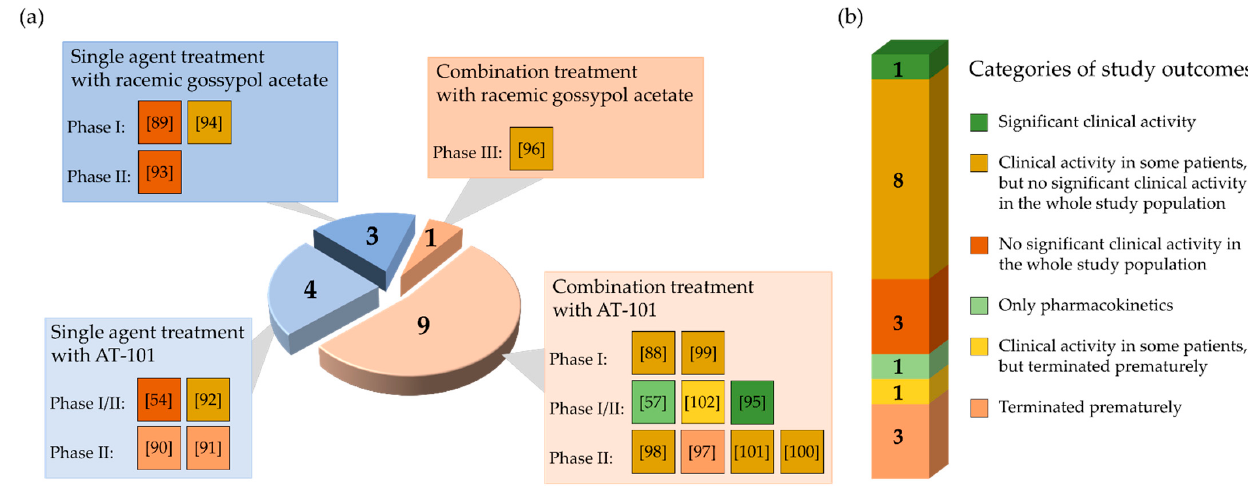
Figure 4. Graphical representation of the results of reviewed studies in cancer clinical trials analyzing the administration of gossypol/AT-101 as a single agent or in combination with standard anticancer treatments. The pie chart is stratified according to study design ( a ) and outcome ( b ). ( a ) The diagram illustrates the total number of conducted clinical trials as a circle. The numbers in the four sections correspond to the number of studies performed in each case. The light blue sections represent the proportion of studies performed with gossypol/AT-101 as single agent, light orange sections represent the proportion of combined therapies (gossypol/AT-101 and standard anticancer protocols). Each section is further subdivided by study phase and contains colored boxes with the corresponding references in brackets. Each color represents one of the study outcomes defined in ( b ). ( b ) The bar divides the study outcomes into six categories. Each of the six different categories contains the number of studies performed and is color-coded according to the study outcome.